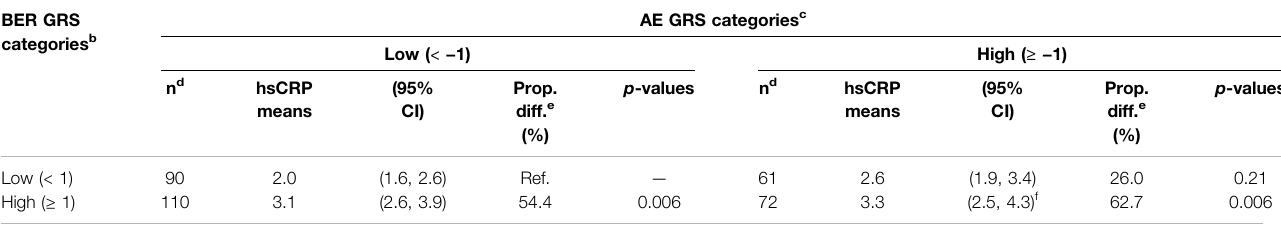
TABLE3| Mean a plasmahighsensitivityC-reactiveproteinconcentrationsaccordingtojointtertilesofantioxidantenzymeandDNAbaseexcisionrepairgeneticriskscores, in the pooled MAP I and MAP II cross-sectional studies ( n =